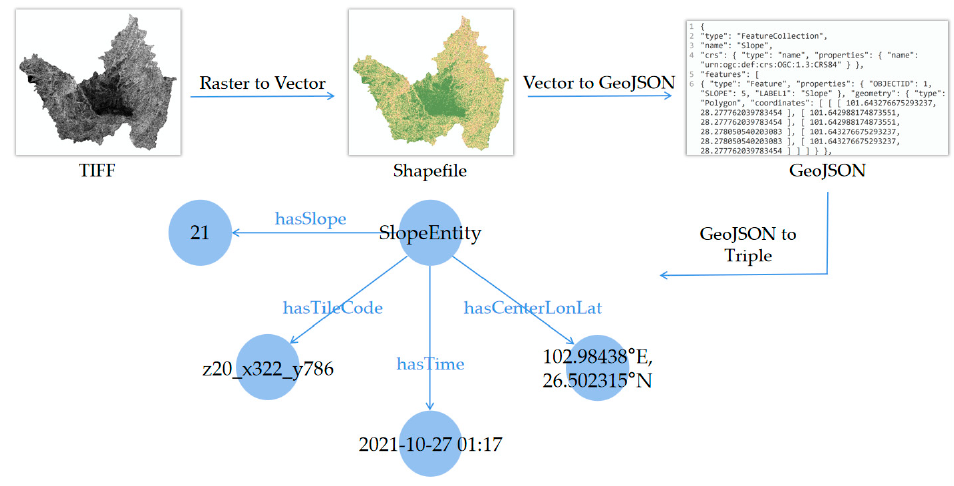
Figure 14. Knowledge extraction process using slope as an example. Forest fire risk prediction needs the theoretical support because the above spatio- temporal data is only a prerequisite for forest fire risk prediction. In this case, the AHP (Analytic Hierarchy Process) is used to evaluate forest fire risk indicators. This paper builds an indicator system for four types of forest fire risk factors: meteorology, terrain, vegetation, and man-made. The weights are shown in Figure 15.